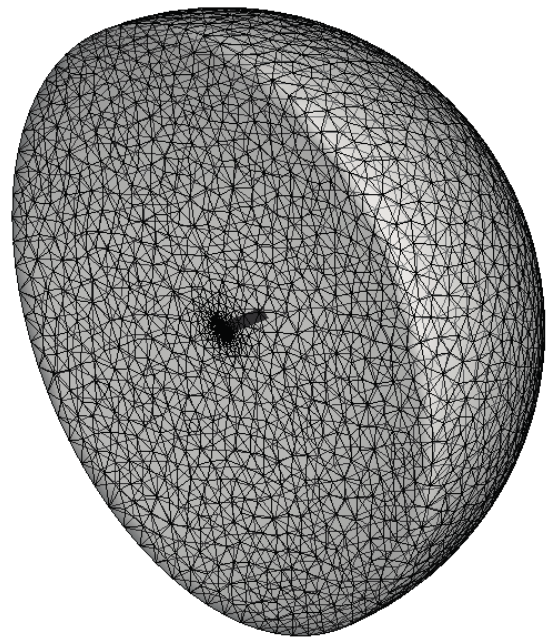
Figure 27. Generated hemisphere outer domain mesh.